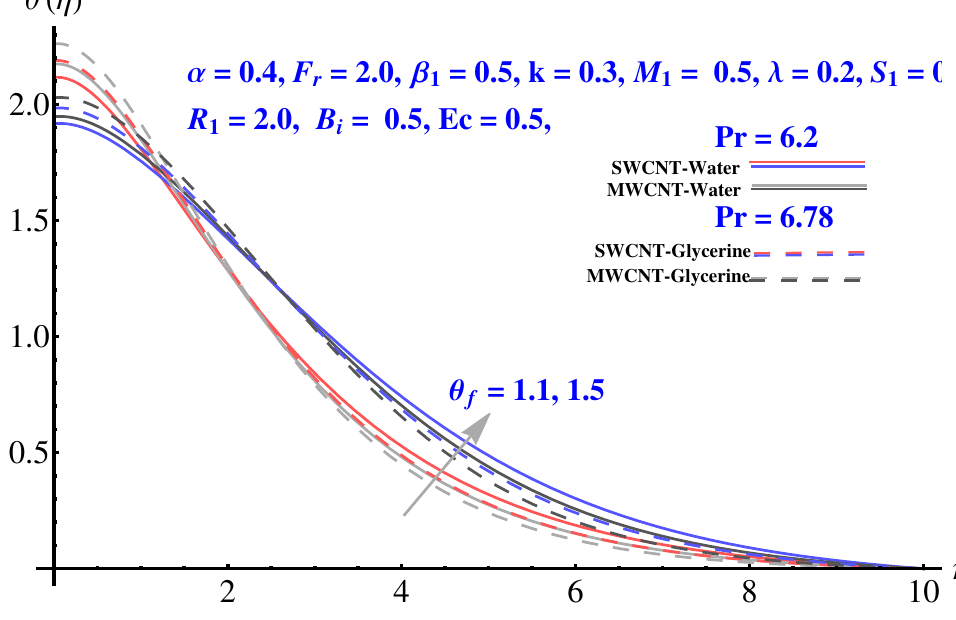
Figure 12. Impact of θ f on temperature